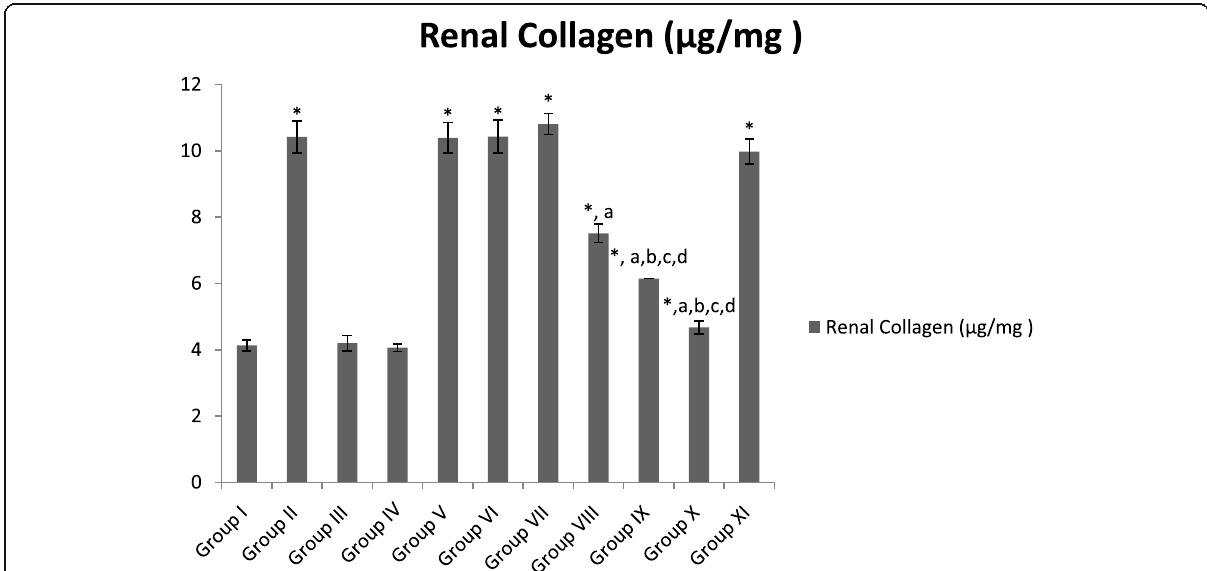
Fig. 5 Graph representing renal collagen levels ( μ g/mg). All values were represented as mean ± SEM. *= p < 0.001 versus group I (normal control); a = p < 0.001 versus group II (uninephrectomised diabetic control); b = p < 0.005 versus group V (uninephrectomised diabetic rats with oleamide (1mg/kg) treatment; c = p < 0.001 versus group VI (uninephrectomised diabetic rats with oleamide (2.5mg/kg) treatment); d = p < 0.001 versus group VI (uninephrectomised diabetic rats with oleomide (5mg/kg)